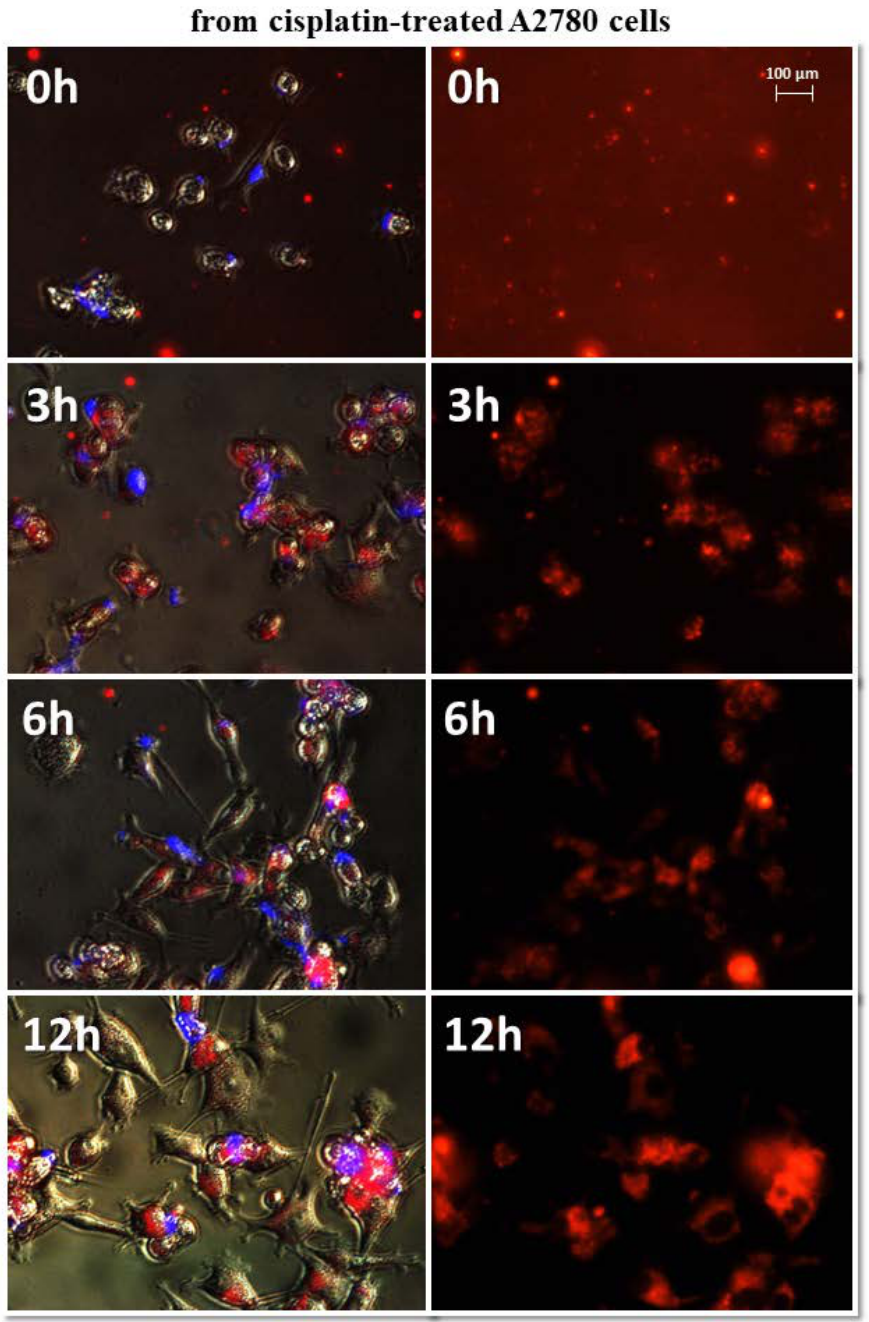
Figure 8. Representative photos of NHDF cells treated with exosomes derived from cisplatin-treated A2780 cells at 0, 3, 6, and 12 h after treatment. Left: merged images of cells in visible light, DAPI stained cells (blue) and Vybrant™ CM-Dil stained exosomes (red), right: Vybrant ™ CM-Dil stained exosomes (red). Nikon Eclipse Ti, magnification × 20.